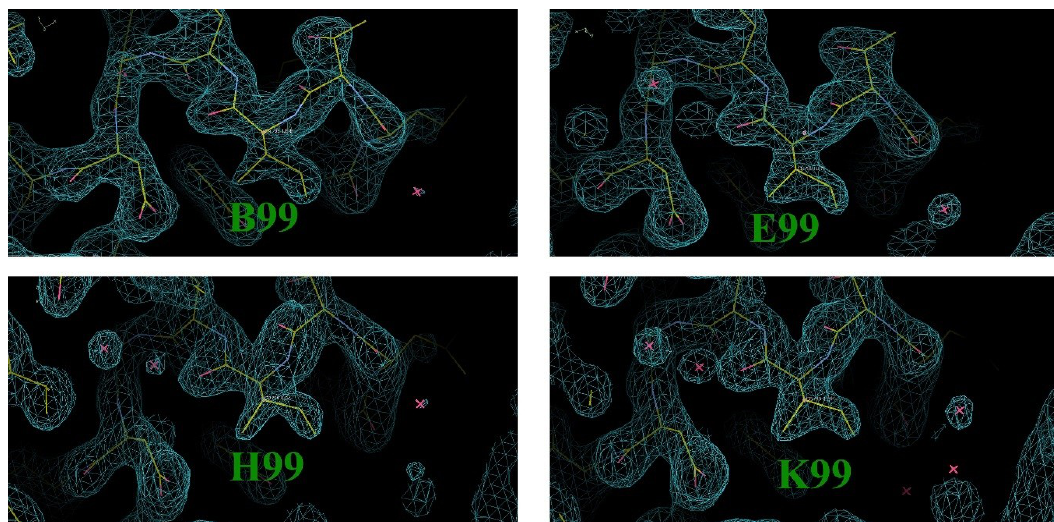
Figure 1. Reduced model bias map of residue Ile99 in the chymotrypsin structure solved in space group P6 5 . A composite omit map ( 2F o -F c , contoured at 1.5 σ ) is displayed as blue mesh and proteins are shown as yellow sticks.